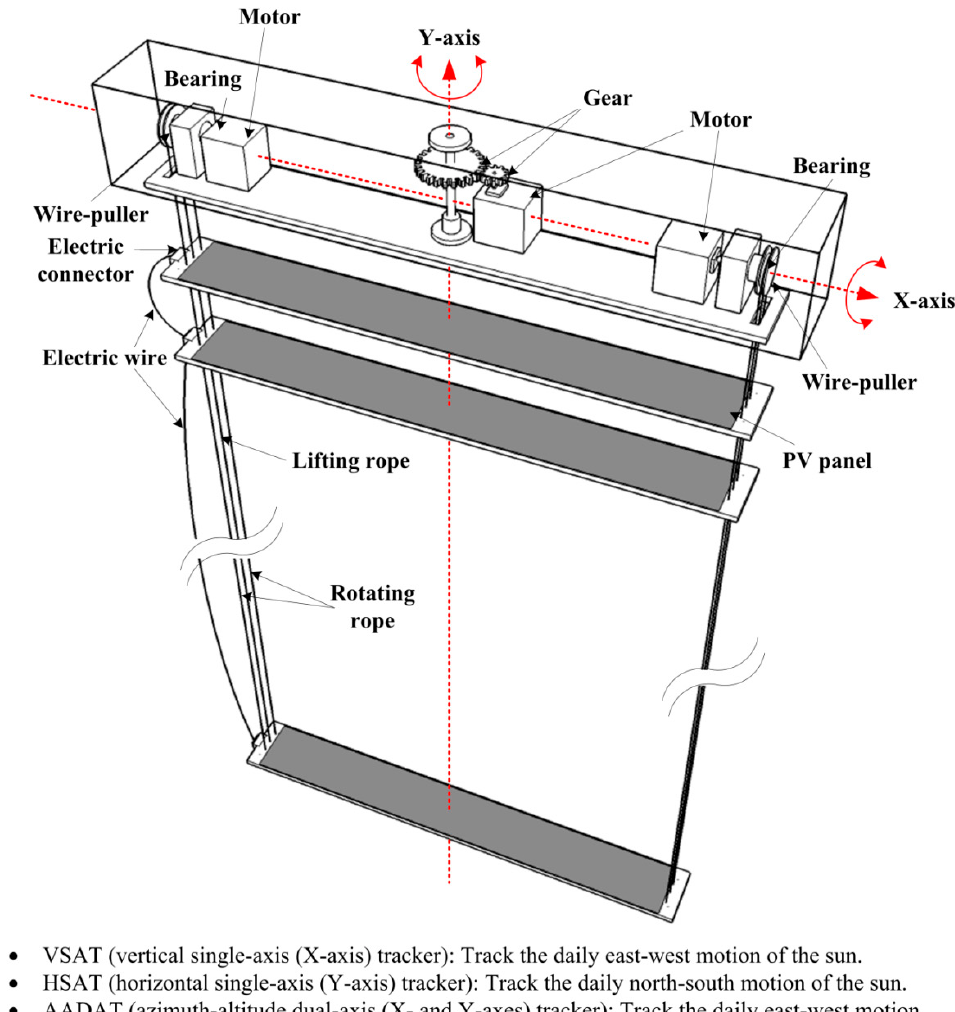
Figure 4. Concept diagram of the third prototype model of the SPSB.